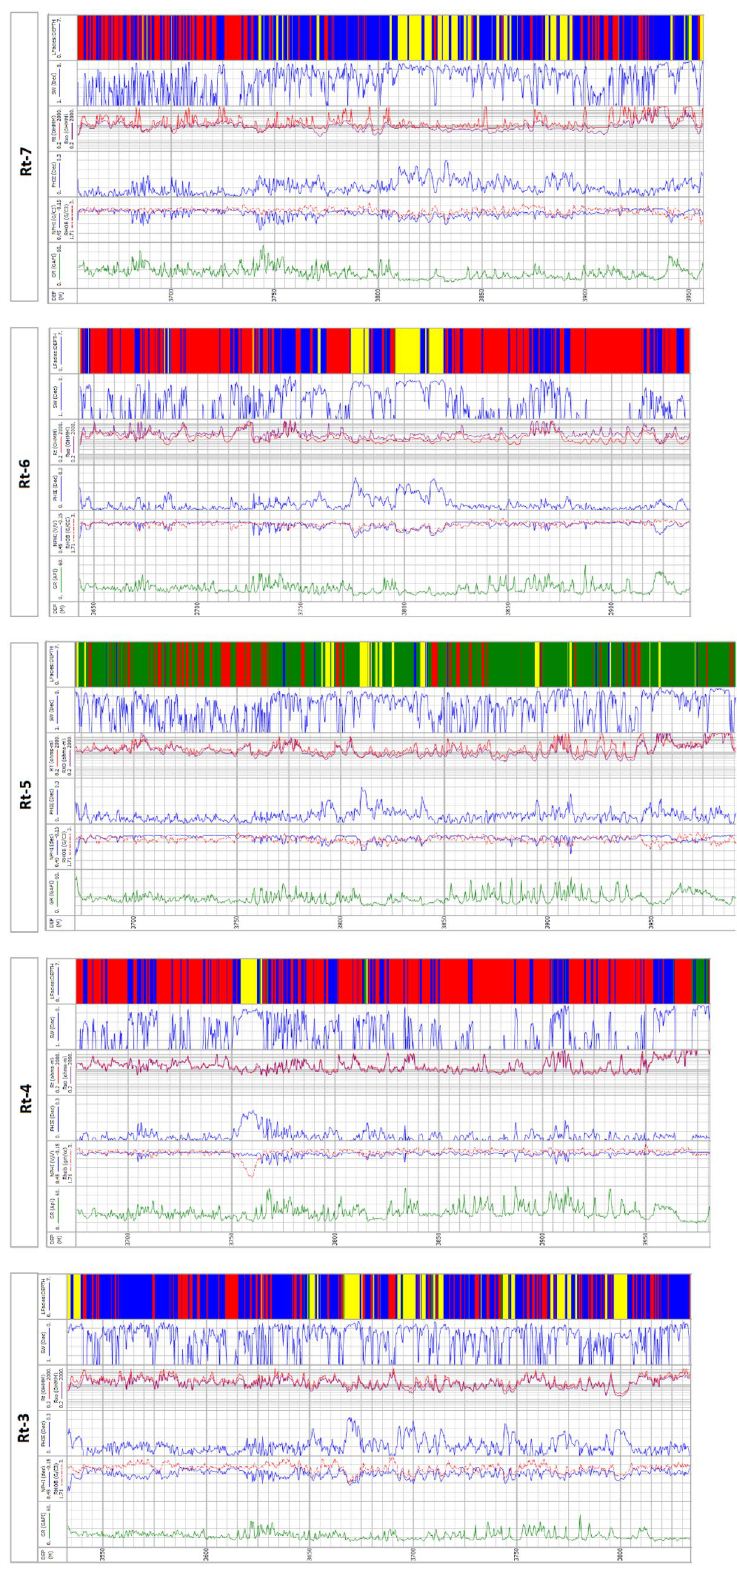
Fig. 17 Rock-type identification for wells Rt-3, 4, 5, 6, and